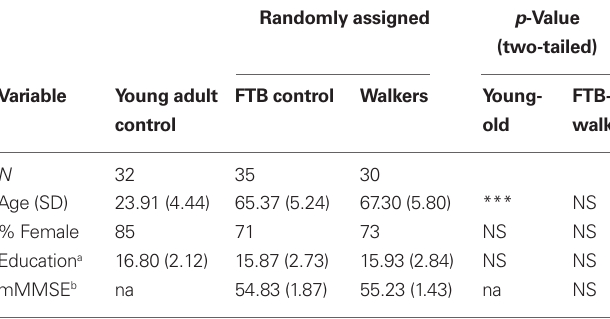
Table 1 | Participant